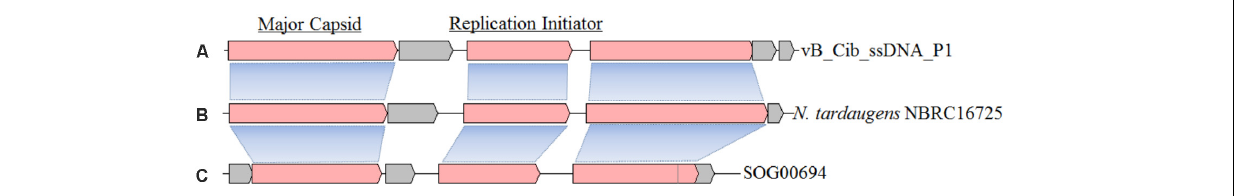
Frontiers in Microbiology |